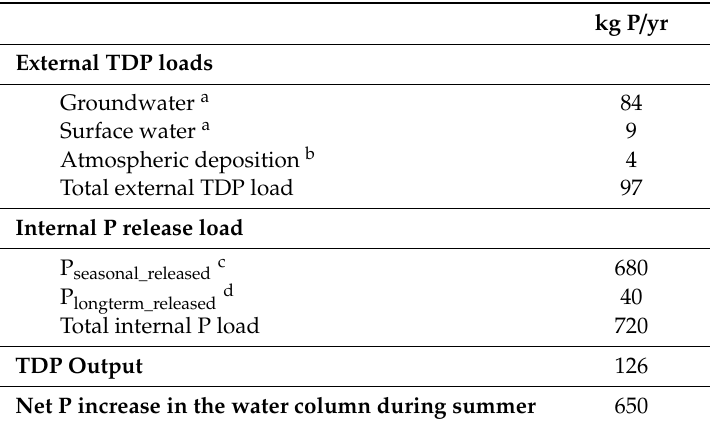
Table 2. Annual P loading to and from Lake Nørresø during 2016 to